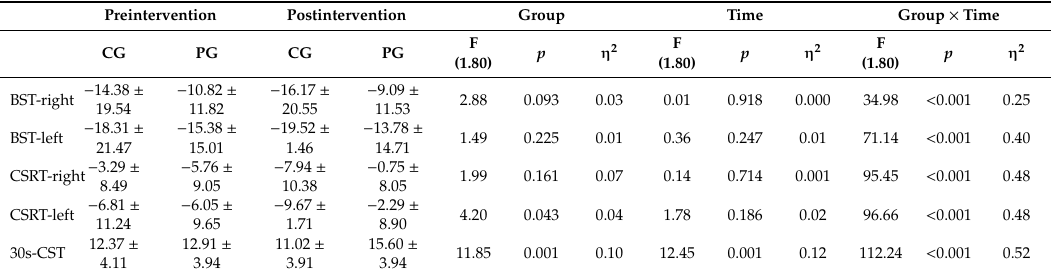
Table 3. E ff ects of Pilates training on functional flexibility and lower-body